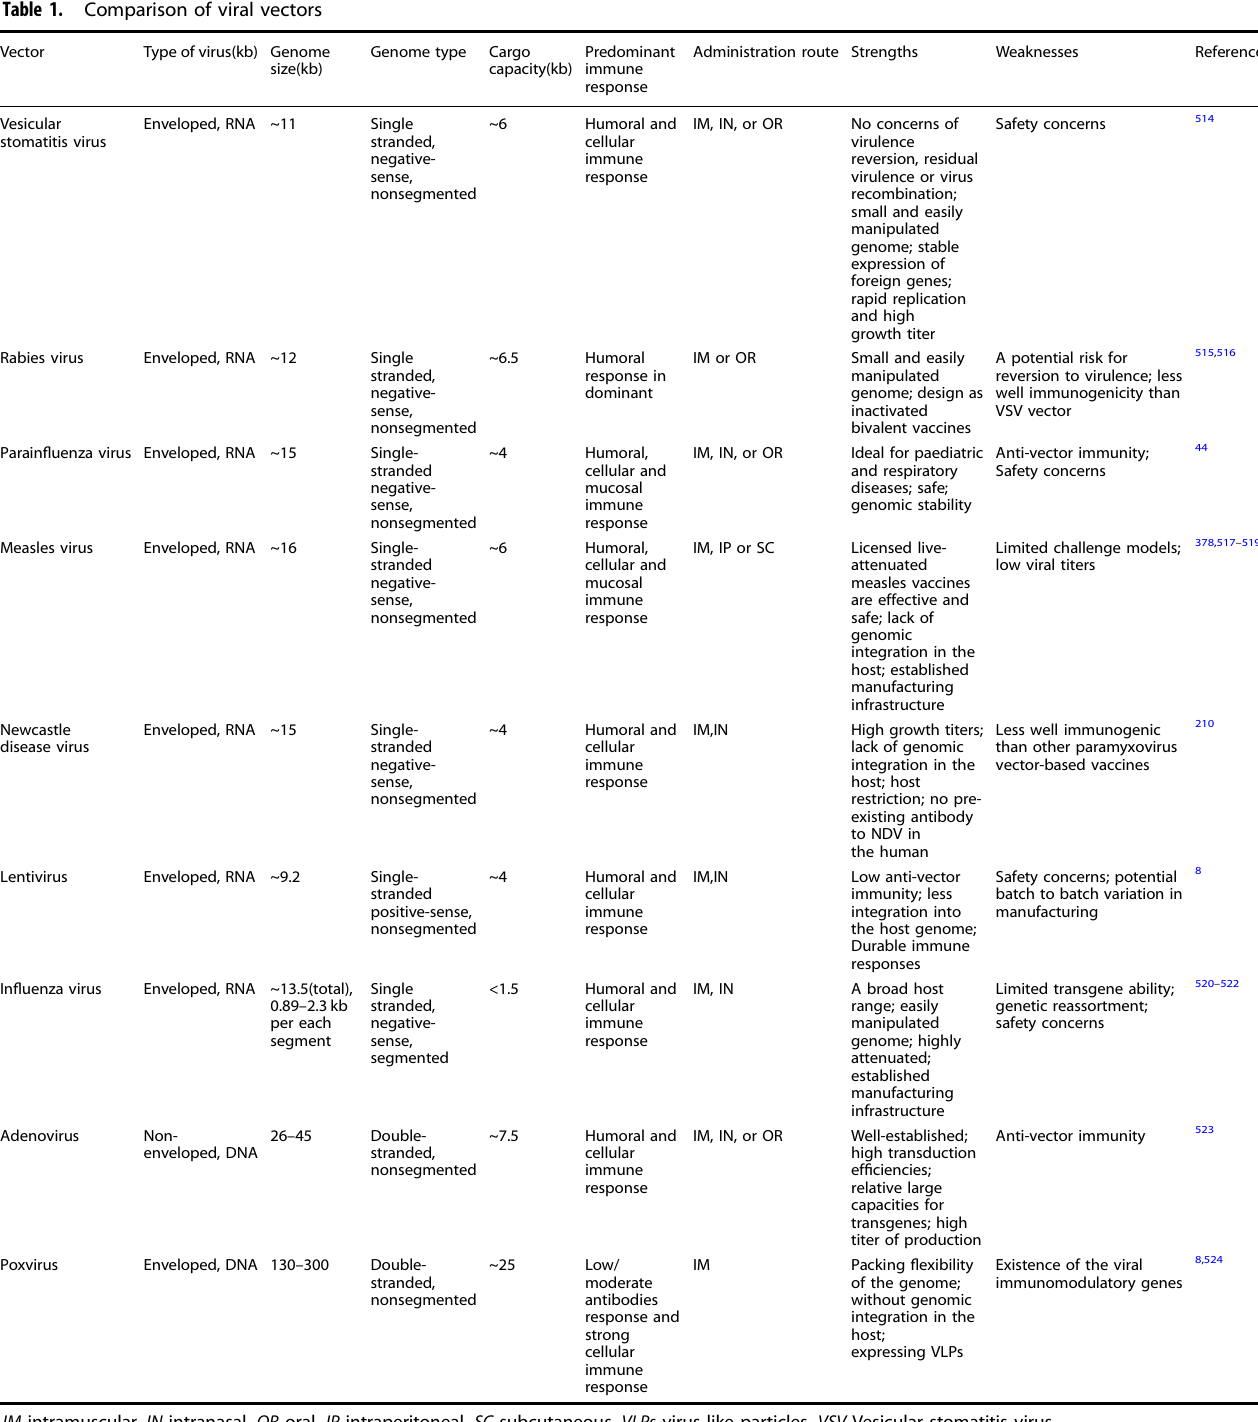
Table 1. Comparison of viral vectors